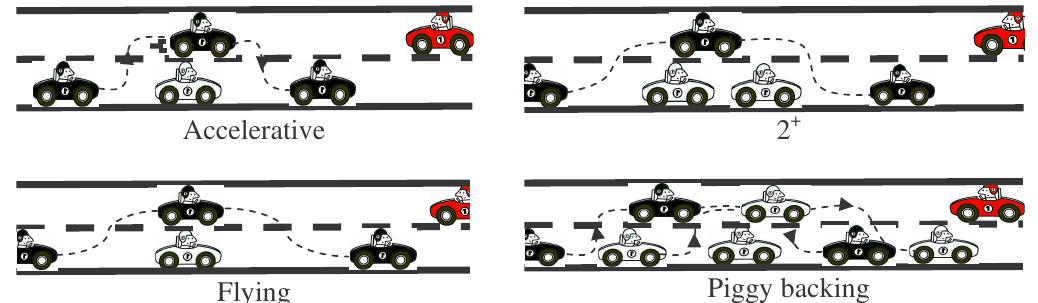
Figure 1. Illustration of the four overtaking